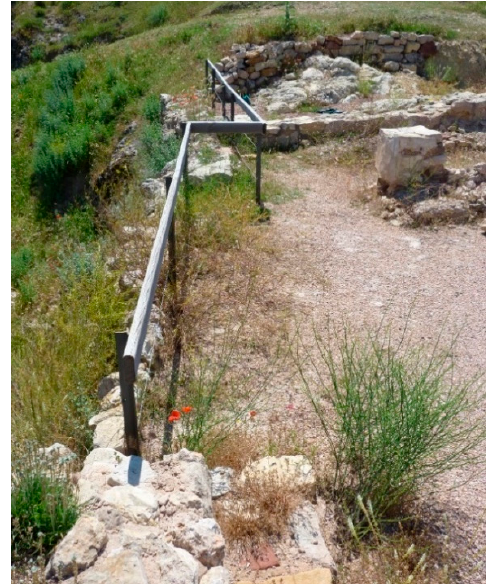
Figure 10. Detail of the north wall at the Molina de Aragón Synagogue archeological site. Author’s photo.